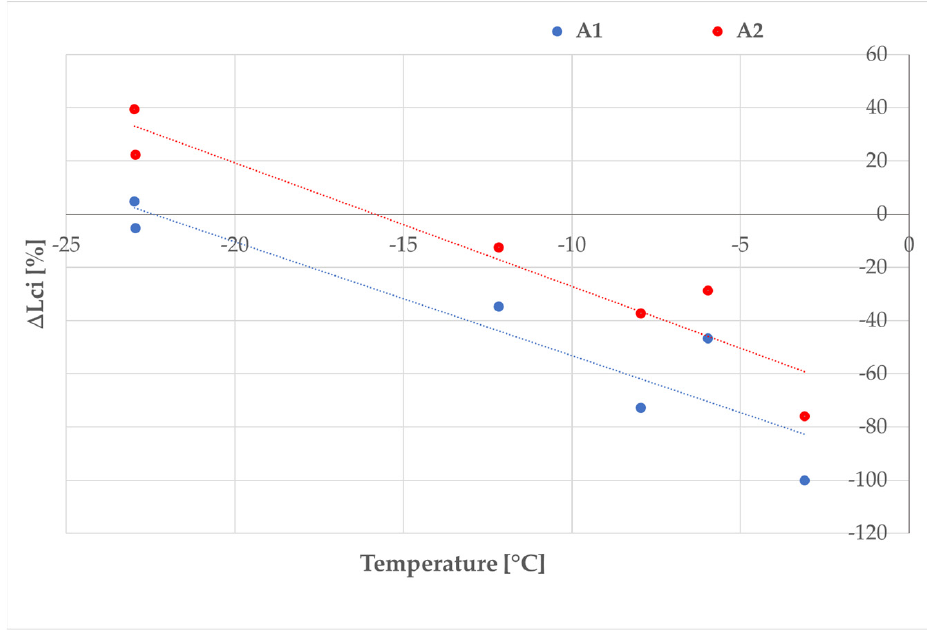
Figure 16. Percentage variation in Lci of coated surfaces with respect to the references as a function of the tests’ temperature.